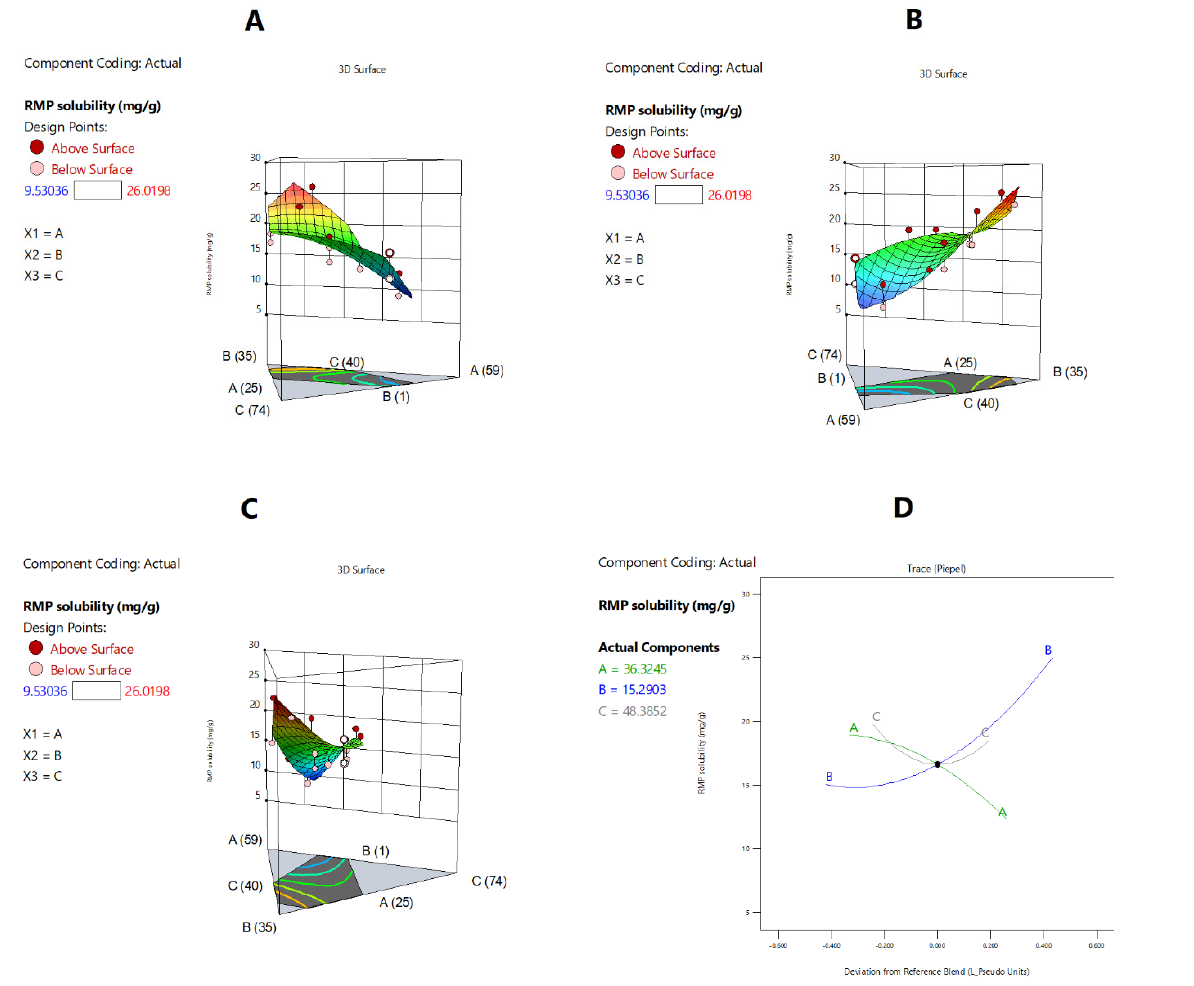
⁽ * ⁾ : Inference for linear mixtures uses type I sums of squares. A: BSO % w / w ; B: TCP % w / w ; C: HCO- 30 % w / w .